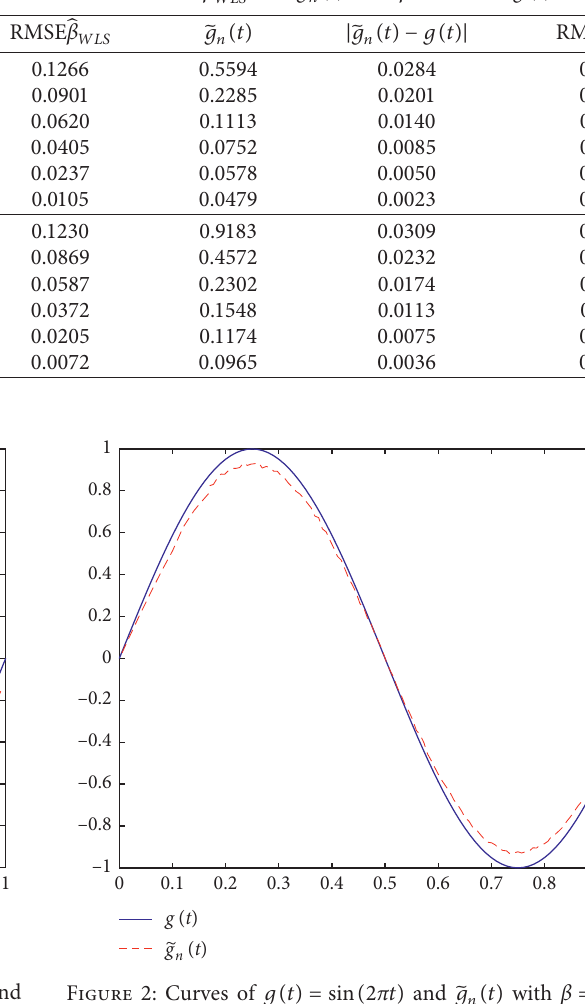
Table 2: The WLS estimators of β and g ( t ) and the absolute errors and RMSEs of 􏽢 β